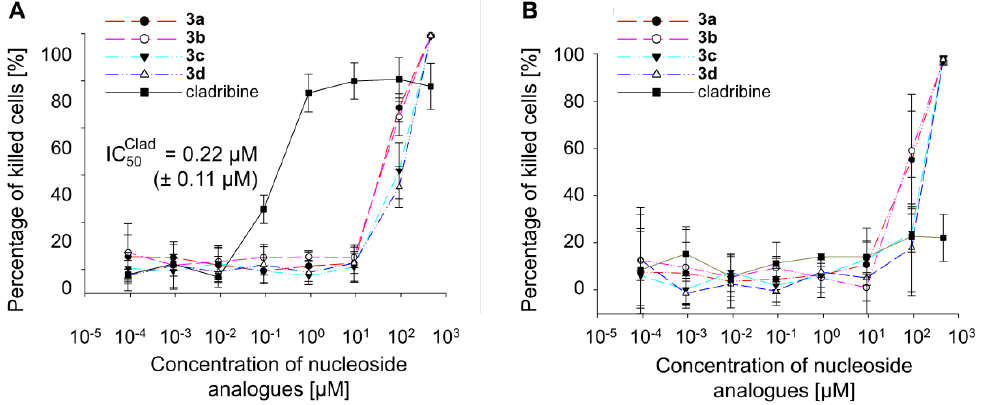
Figure 2. Biological activity of dihalogenated nucleoside analogues in the leukemia cell line HL-60 ( A ) or the control cell line HEK293 ( B ). Nucleoside analogues were serially diluted, and the percentage of killed cells was determined by XTT